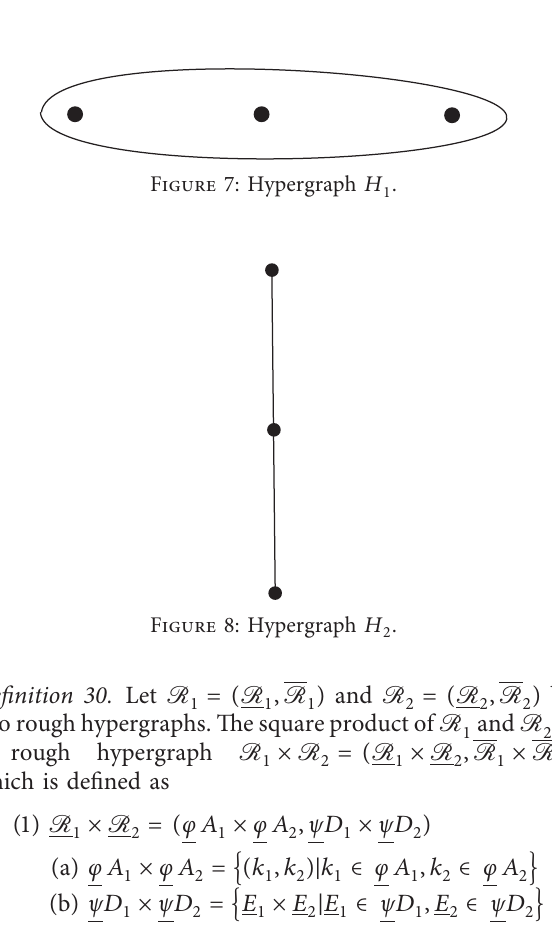
Figure 7: Hypergraph H